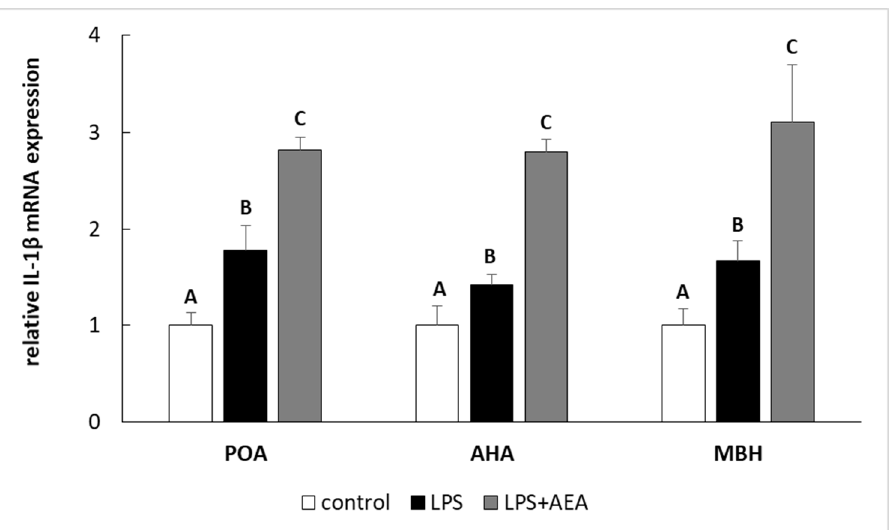
Figure 2. The effect of intravenous (i.v.) anandamide (AEA) injection (10 µ g/kg; i.v.) and lipopolysaccharide (LPS)-induced inflammation (400 ng/mg; i.v.) on the relative interleukin (IL)-1 β mRNA level in preoptic area (POA), anterior hypothalamus (AHA), and medial basal hypothalamus (MBH) normalized to the mean expression of three reference genes ( GAPDH , HDAC1 , ACTB —see Table 2.). All data are presented as the mean value ± S.E.M. Different letters indicate significant ( p < 0.05) differences according to a one-way ANOVA followed by Fisher’s least significance test.